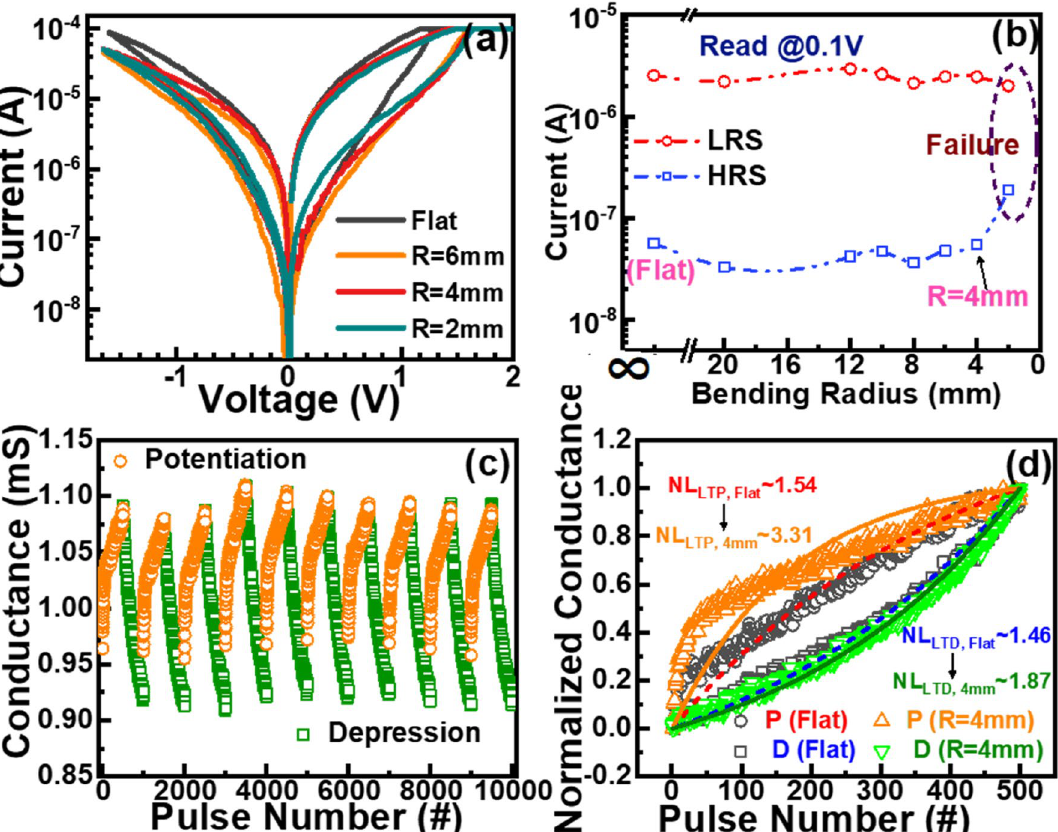
Figure 5. ( a ) Bipolar I–V curves at a different bending radius of the ISHI-1 device. ( b ) Variation of LRS and HRS with the bending radius. ( c ) 10 cycles of LTP/LTD after 4 mm bending and ( d ) nonlinear fitting comparison of a typical LTP/LTD of flat (dash line) with that after 4 mm